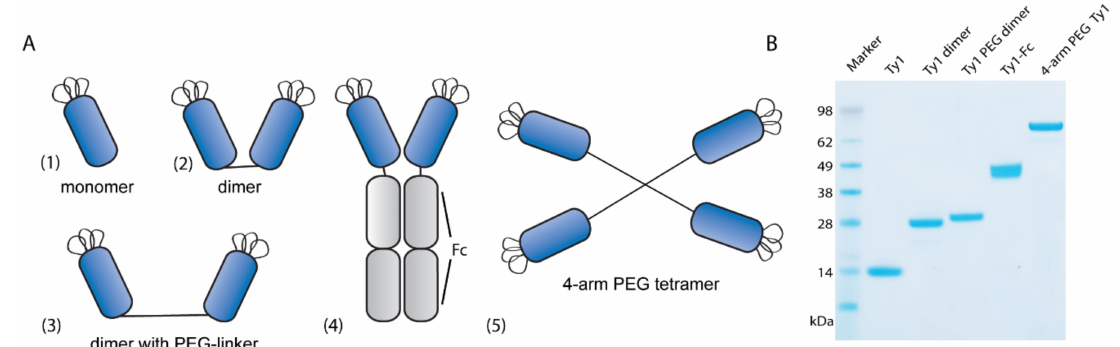
Figure 2. Overview of the generated constructs. ( A ) (1) Ty1 monomer, (2) Ty1-dimer generated as described in Figure 1B, (3) Ty1 dimer with PEG linker, generated by performing a click reaction of Ty1-azide and bis-PEG11-DBCO, (4) Ty1-Fc, dimerization through Fc fusion and expression in mammalian 293F cells [27], (5) 4-arm PEG10K Ty1, generated by performing click reaction of Ty1-DBCO to 4-arm PEG10K-azide. ( B ) Nanobody constructs were loaded on SDS-PAGE and stained using Coomassie G-250. Then 2 ug of each construct was loaded on the gel; molecular weight is indicated on the left